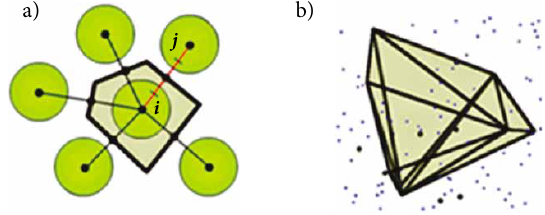
Fig. 9. Generation of the Voronoi cell: a – two-dimensional principal scheme of generation; b – Voronoi cell of the i th particle in the mixture (black points show the neighbours of the i th particle used for Voronoi cell generation, blue points indicate other particles in the mixture) 10 pav. Priklausomybė tarp vidutinio koordinacijos